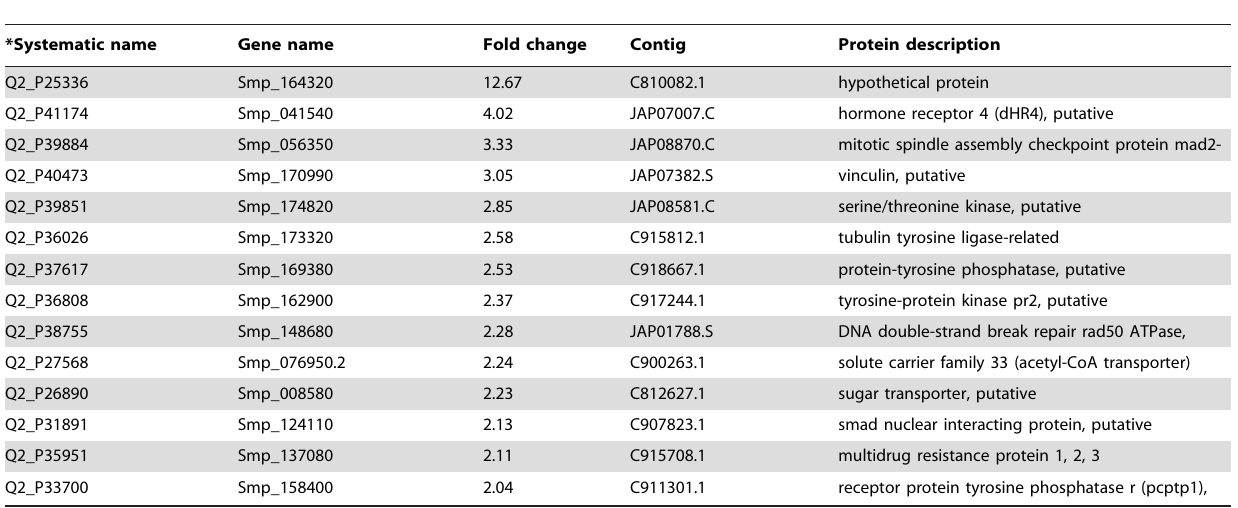
Table 2. A selection of differentially up-regulated genes of the vitelline tissue normalised to the whole female